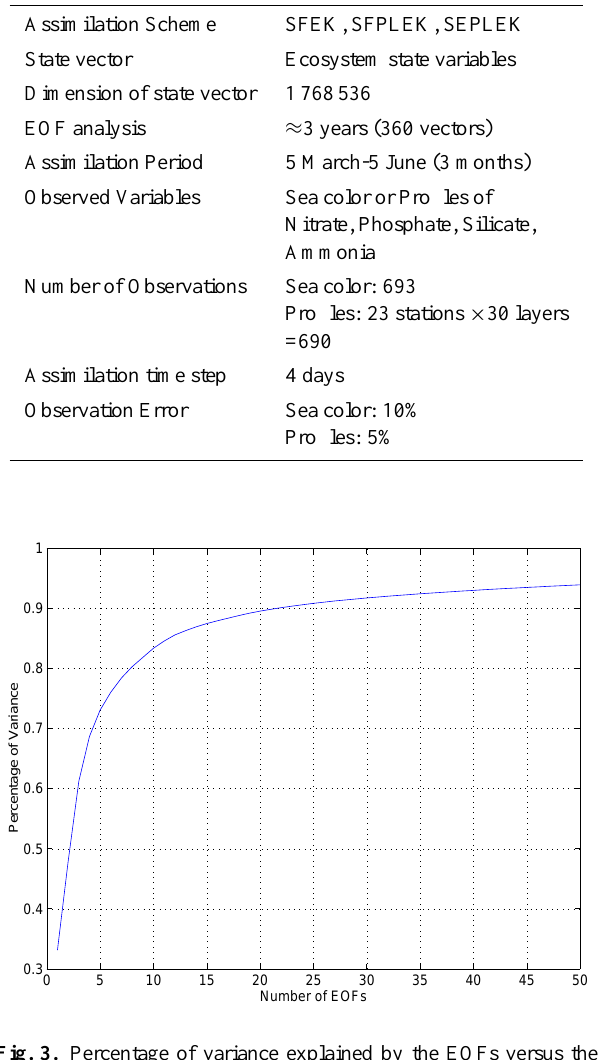
Table 1. Twin experiments setup.